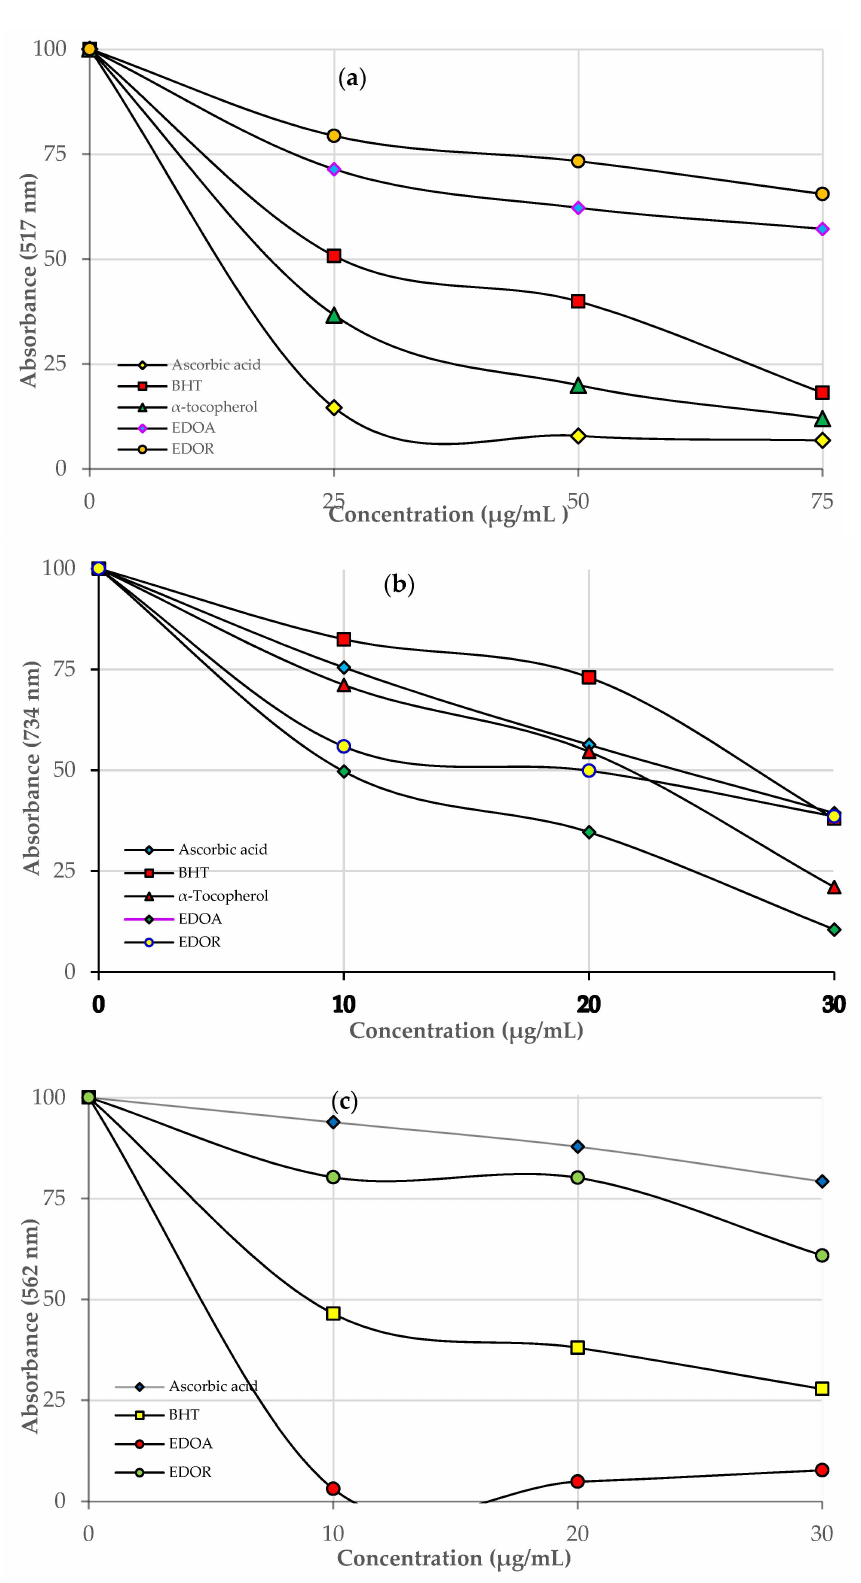
Figure 1. Radical scavenging ability of ethanol extracts of aerial parts (EDOA) and roots (EDOR) of sahlep ( D. osmanica ) and standards: ( a ) DPPH assay; ( b ) ABTS scavenging; ( c ) Fe2+